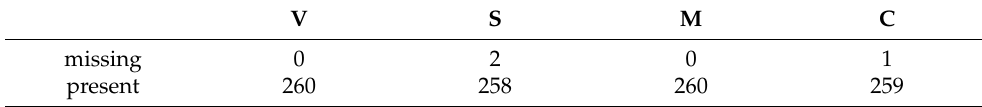
Table 5. Missing data on translation time, by subject.